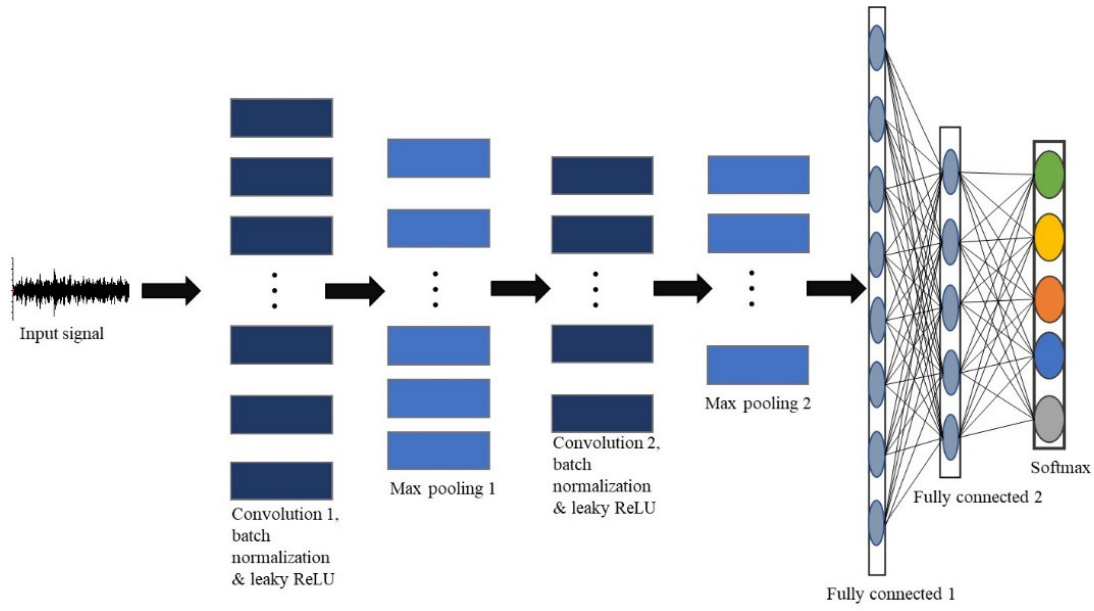
Figure 6. A simple and compact 1D CNN architecture for the DBFD model.